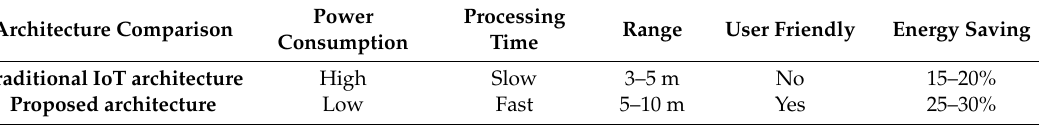
Table 3. Performance characteristics table comparing traditional and proposed Internet of Things (IoT)